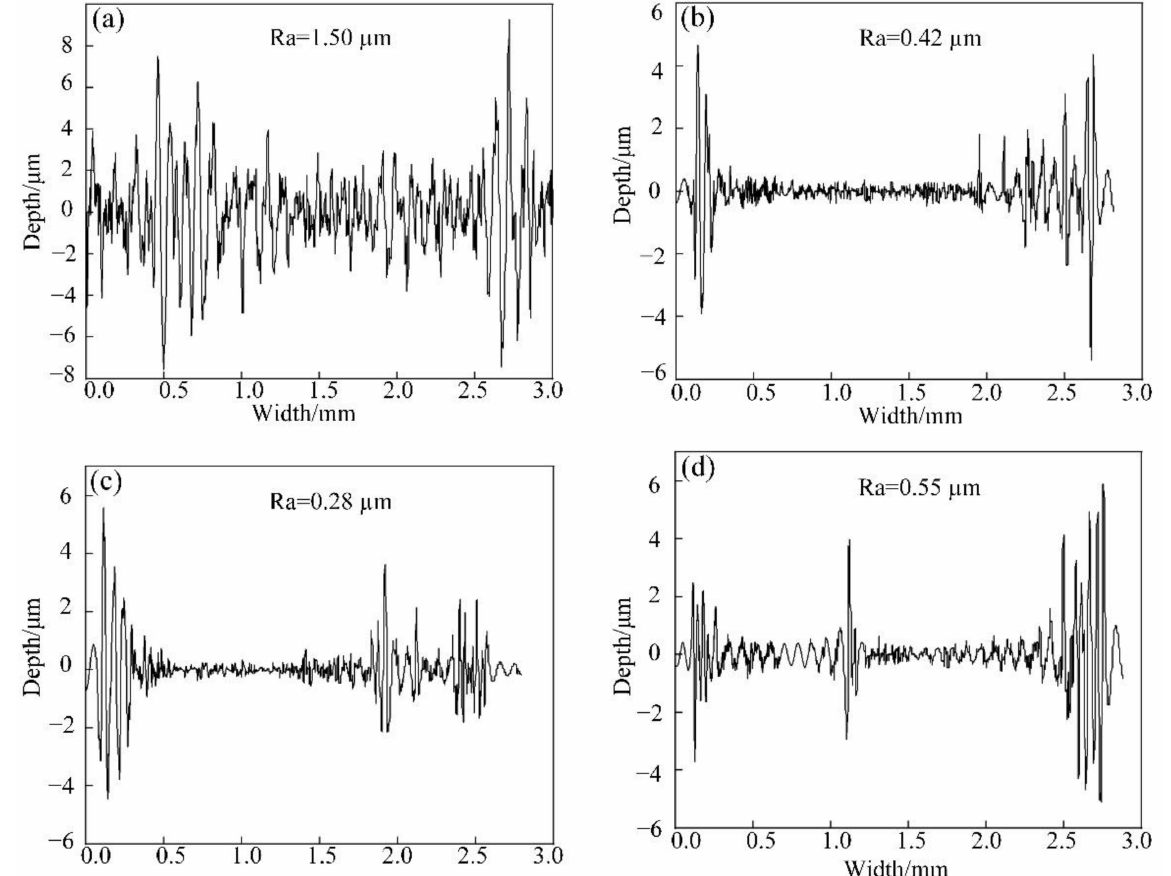
Figure 13. The worn surface roughness curves of the coatings with different Ni-MoS 2 contents and substrate. ( a ) Ti6Al4V. ( b ) The 25 wt.% Ni-MoS 2 coating. ( c ) The 35 wt.% Ni-MoS 2 coating. ( d ) The 45 wt.% Ni-MoS 2